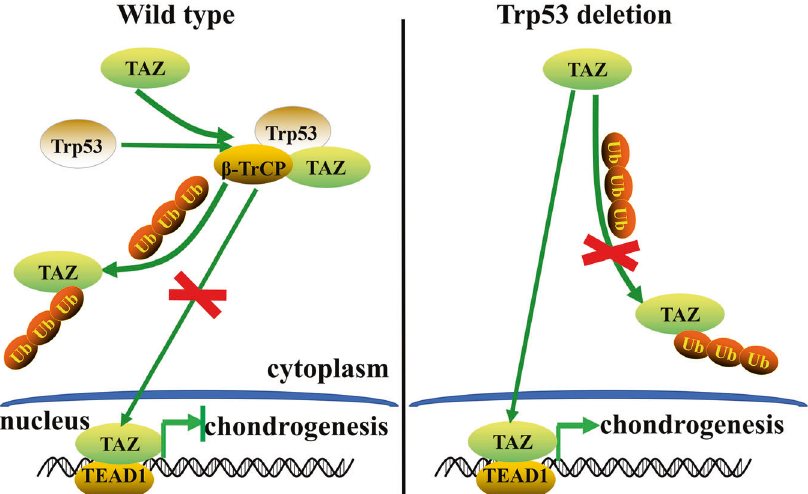
Fig. 7 Trp53 modulates chondrogenesis and endochondral ossi fi cation through TAZ signaling. In normal conditions, Trp53 interacts with TAZ to inhibit its nuclear translocation, and promotes its degradation through β -TrCP-mediated ubiquitination, which ultimately causes a decreased